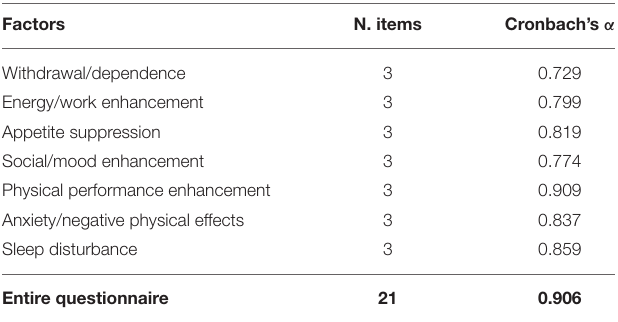
TABLE 1 | Internal consistency of the brief version of Caffeine Expectancy Questionnaire in Brazil (B-CaffEQ-BR) ( n = 62 A ). Factors N.